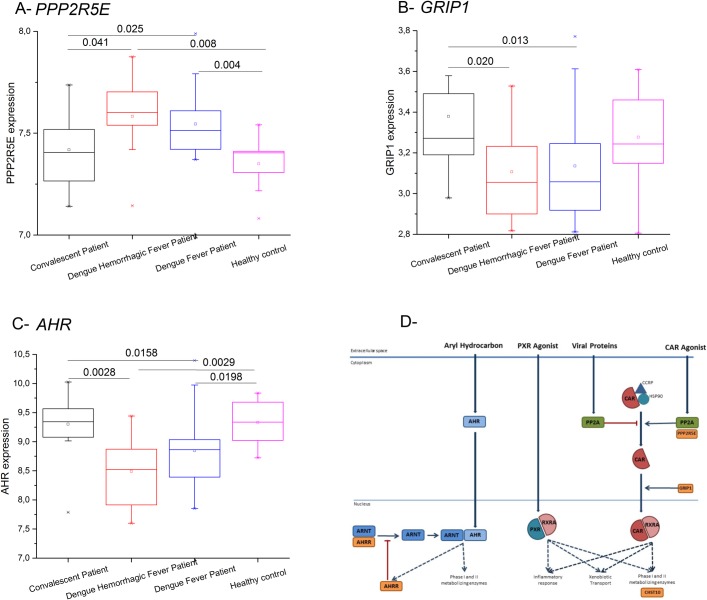
Significantly altered gene expression for PPP2R5E (A), GRIP1 (B) and AHR (C) in Thai dengue cohort along the course of disease from a transcriptome dataset for whole blood[17]. Significant p-values are indicated. D) Scheme of the xenobiotic metabolism signalling pathway (based on Ingenuity database information), highlighting the three nuclear transcription factors: the constitutive active receptor (CAR); the pregnane X receptor (PXR); and the aryl hydrocarbon receptor (AHR).